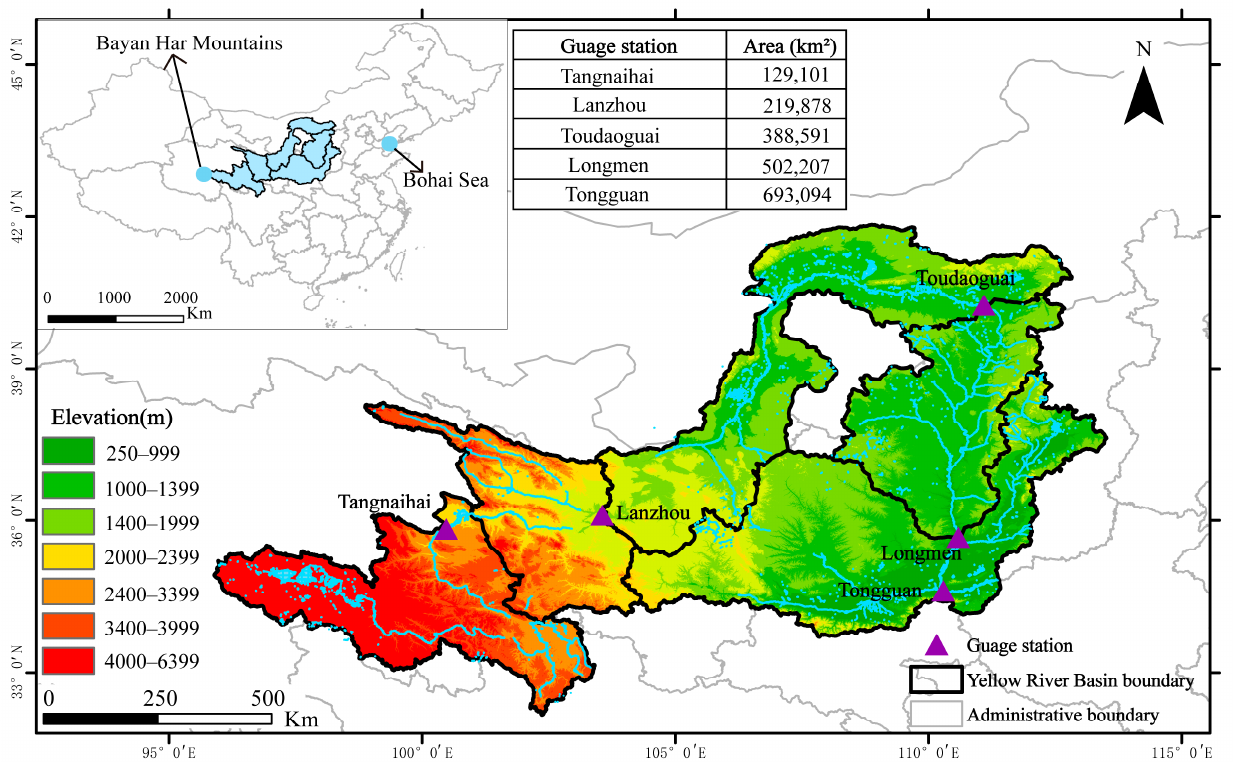
Figure 1. Topographic map and gauge station distribution in the study area.